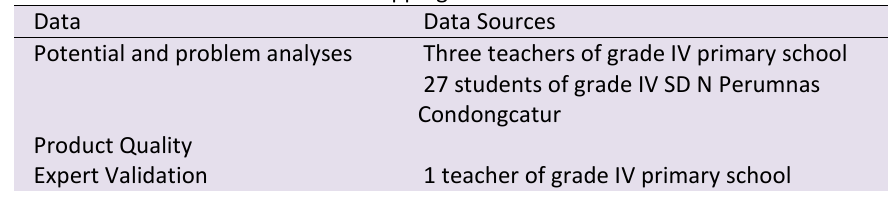
Table 1 . Data Mapping and Data